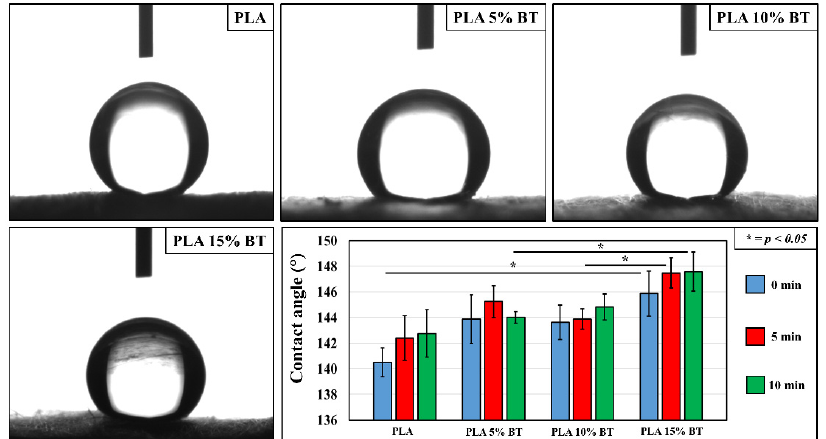
Figure 3. Images of water contact angle measurements on Polylactic acid (PLA) fibers and composites before the aging test. The graph represents the value of the contact angle for all the substrates analyzed before and after the UV/O 3 exposure. For each substrate, five different points have been tested.